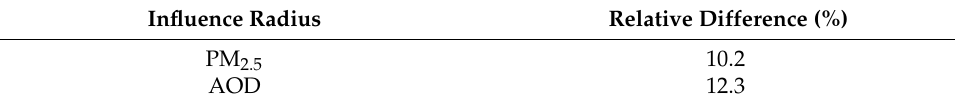
Table 5. Temporal and spatial sum of relative differences between the simulations whereby the influence radius is set to twice and equal to the average spacing of observations.